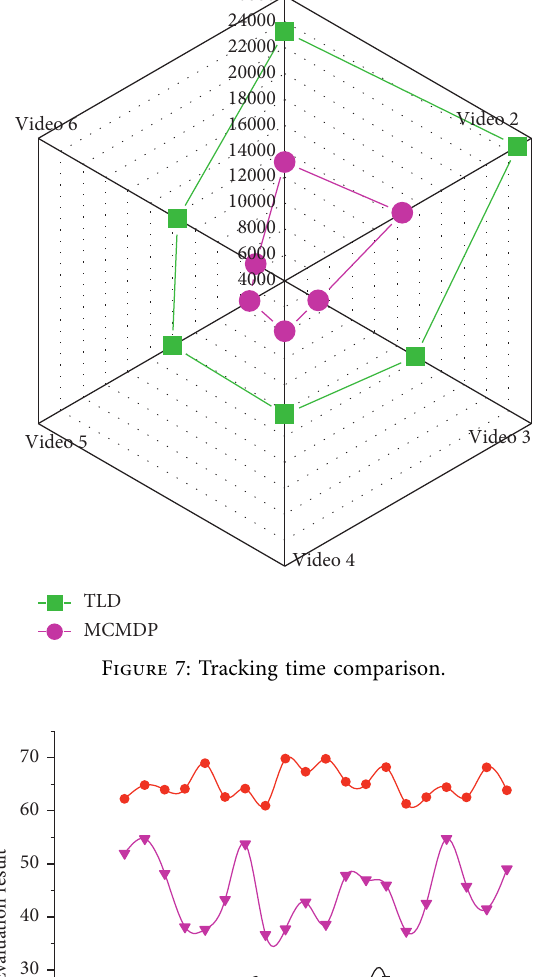
Figure 8: Test evaluation results.